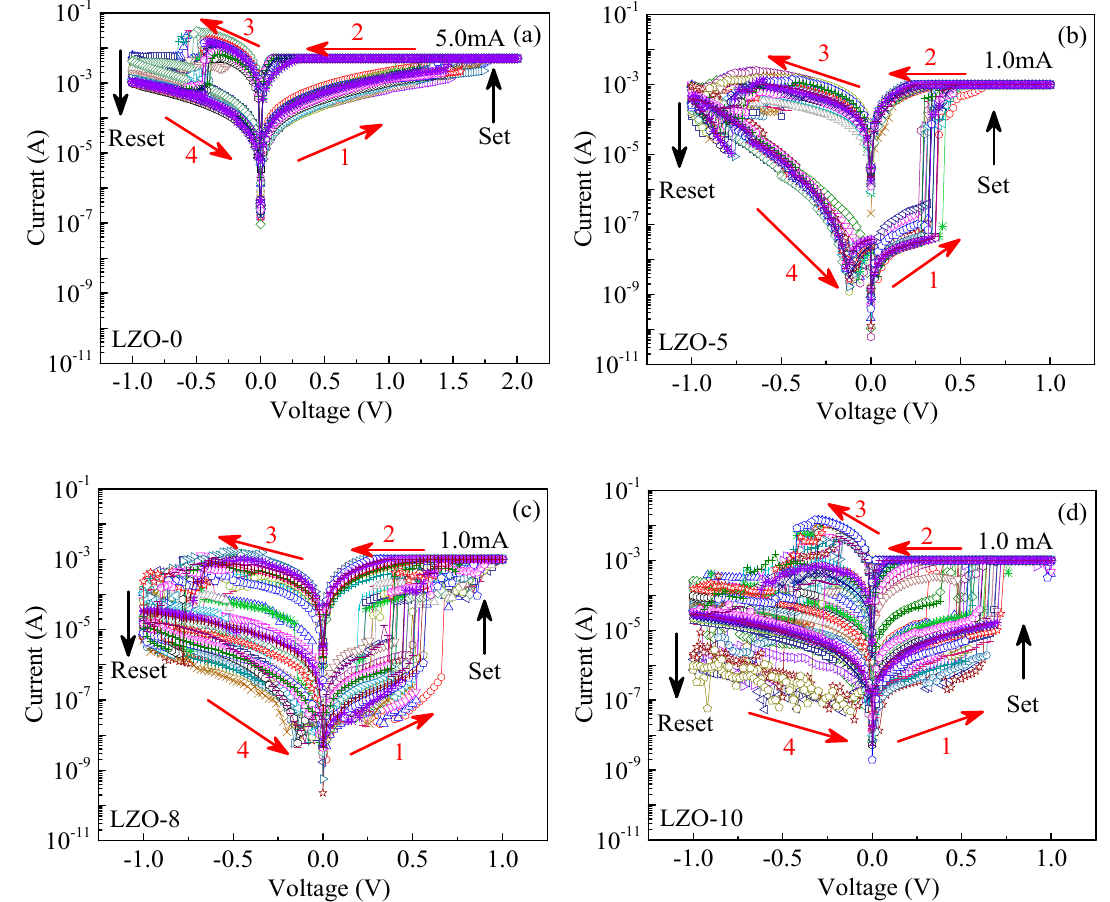
Figure 5. The I – V curves of resistive switching devices under DC voltages: ( a ) LZO-0; ( b ) LZO-5; ( c ) LZO-8; ( d ) LZO-10.